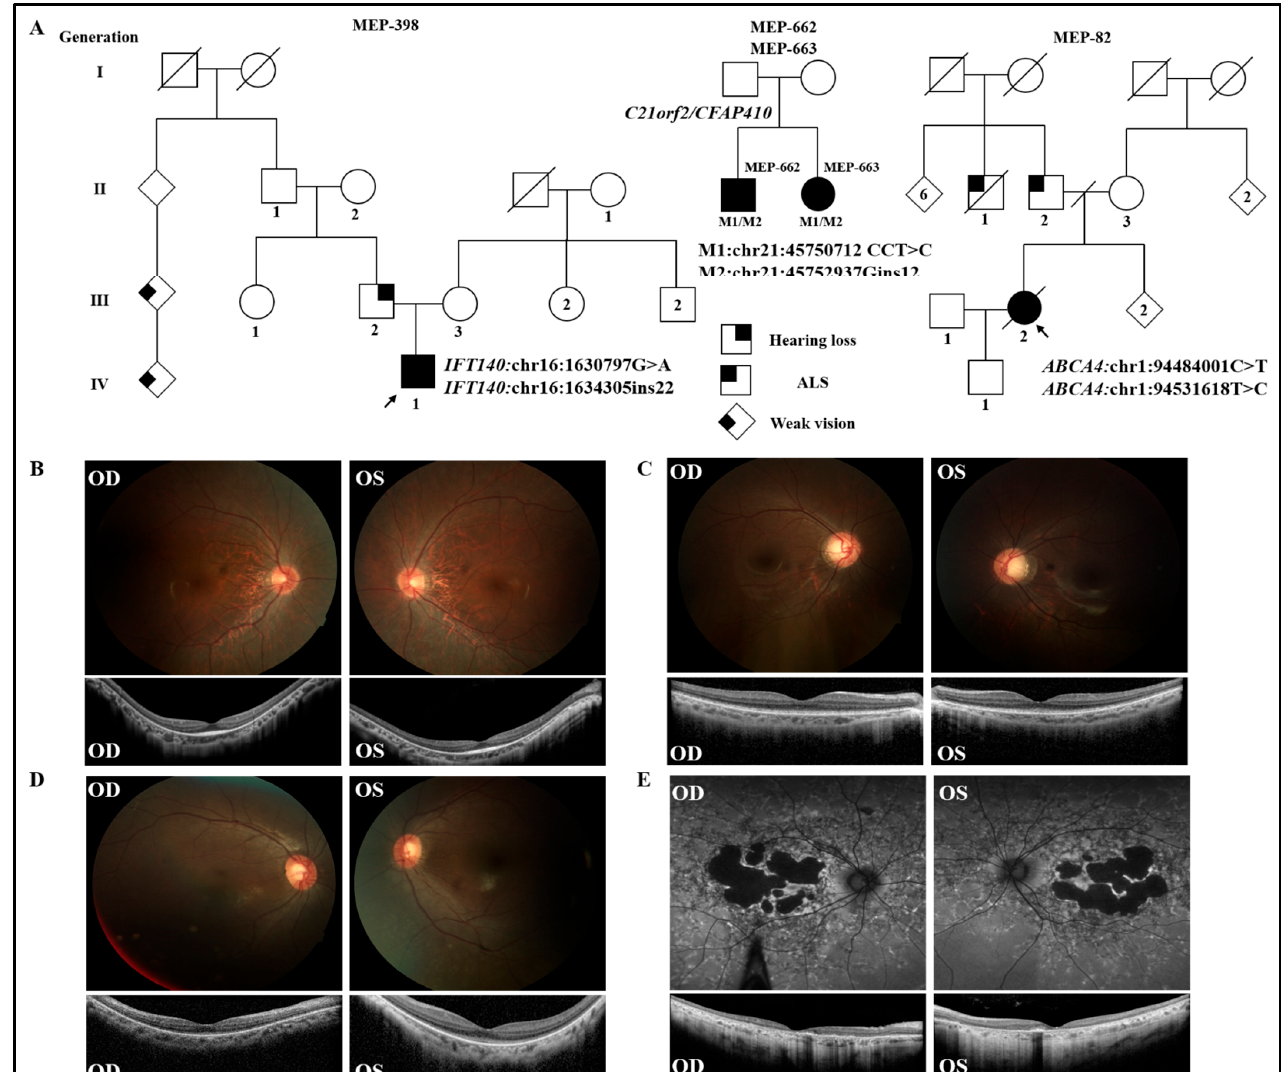
Figure 3. Clinical data of probands affected with IRD. ( A ) Pedigrees of probands (MEP-398 and MEP-662/663) and MEP-082. Symbols represent: females (circles), males (squares), unknown sex (diamonds), affected individuals (filled symbols), unaffected individuals (open symbols), numbers of siblings (numbers in symbols), and deceased (oblique line through symbol) ( B ) Fundus autofluo- rescence (AF) and optical coherence tomography (OCT) of MEP-398. ( C ) AF and OCT of MEP-662. ( D ) AF and OCT of MEP-663. (E) AF and OCT of MEP-082.